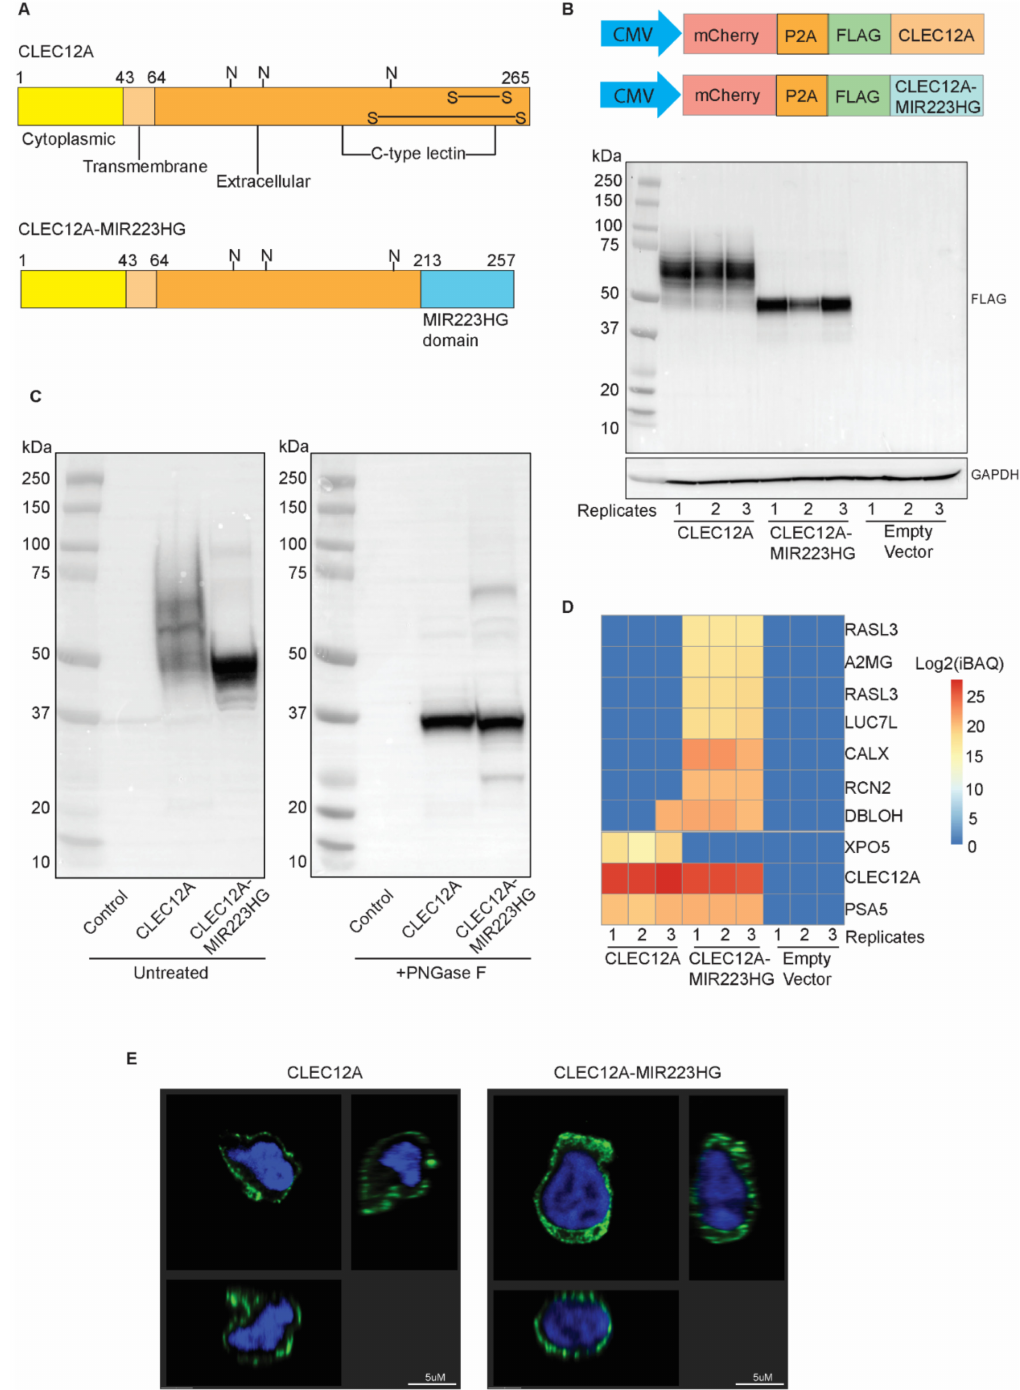
Figure 3. CLEC12A-MIR223HG encodes a chimeric protein distinct from CLEC12A. ( A ) Schematic of CLEC12A and CLEC12A-MIR223HG protein architectures. ( B ) Western blot image of cell lysates from HEK293 cells transduced with lentiviral vectors expressing either CLEC12A or CLEC12A-MIR223HG . ( C ) Western blot image of PNGase F-treated and untreated U-937 cell lysates overexpressing CLEC12A or CLEC12A-MIR223HG . ( D ) Immunoprecipitation with anti-FLAG antibody coupled with mass spectrometry of U-937 cells expressing either CLEC12A or CLEC12A-MIR223HG . Total peptide intensity divided by the number of observable peptides for a particular protein (iBAQ) is depicted. Compared to CLEC12A, the chimeric protein has gained interacting partners and lost at least one. Three separate replicates were performed. ( E ) Representative images of immunofluorescence with anti-FLAG antibody (green) and DAPI (blue) of U-937 cells expressing either CLEC12A or CLEC12A-MIR223HG . Image analysis was performed using Biplane Imaris software. Three different angels of the same cell are